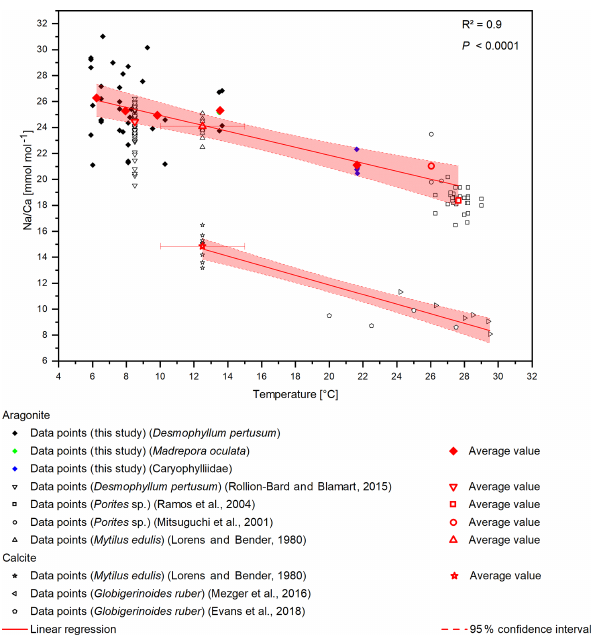
Figure 6. Compiled Na / Ca ratios from different studies. D. per- tusum , M. oculata , M. edulis and Porites sp. show a negative lin- ear relation with water temperature. R 2 relates only to the arag- onitic samples. Calcitic samples from M. edulis and Globigeri- noides ruber show the same sensitivity, albeit with an offset of 10mmolmol − 1 . Temperature for the data from Lorens and Bender (1980) amounts to the average temperature of the tank the corals were cultivated in, while the error bars show maximum and mini- mum